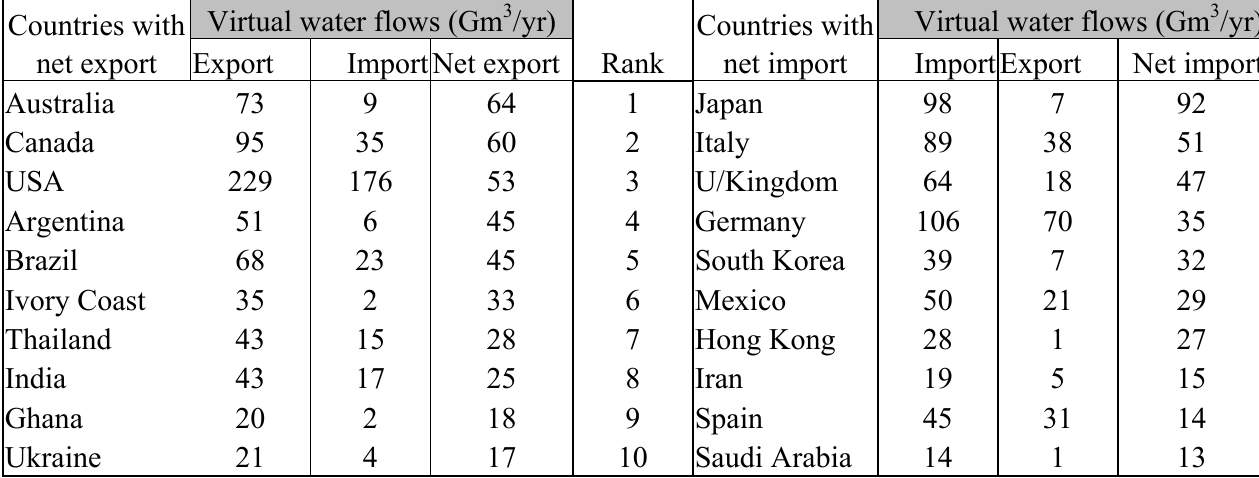
Table 4b. Top-10 of net virtual water exporters and top-10 of net virtual water importers for the period 1997–2001. [Source: Hoekstra, A.Y., Chapagain, A.K., Globalization of water: Sharing the planet's freshwater resources: Blackwell Publishing, Oxford, UK, 2008]. Countries